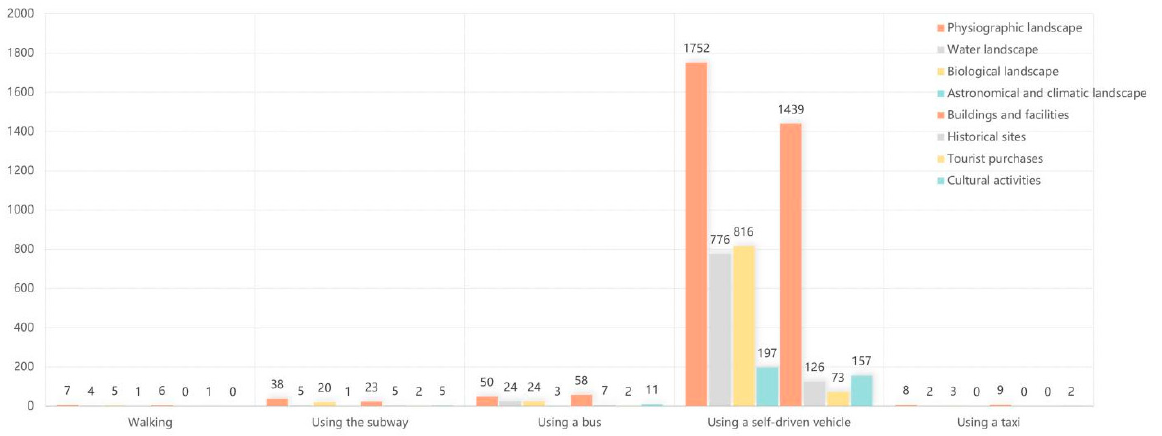
Figure 5. Analysis of tourists’ landscape preferences when using different modes of transportation.